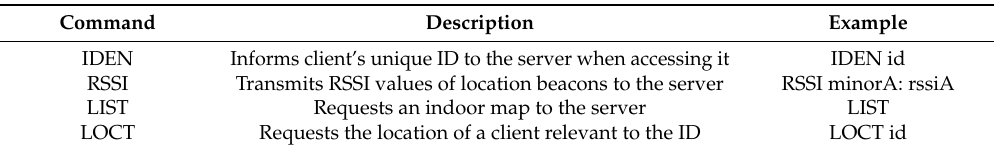
Table 2. Commands for client.